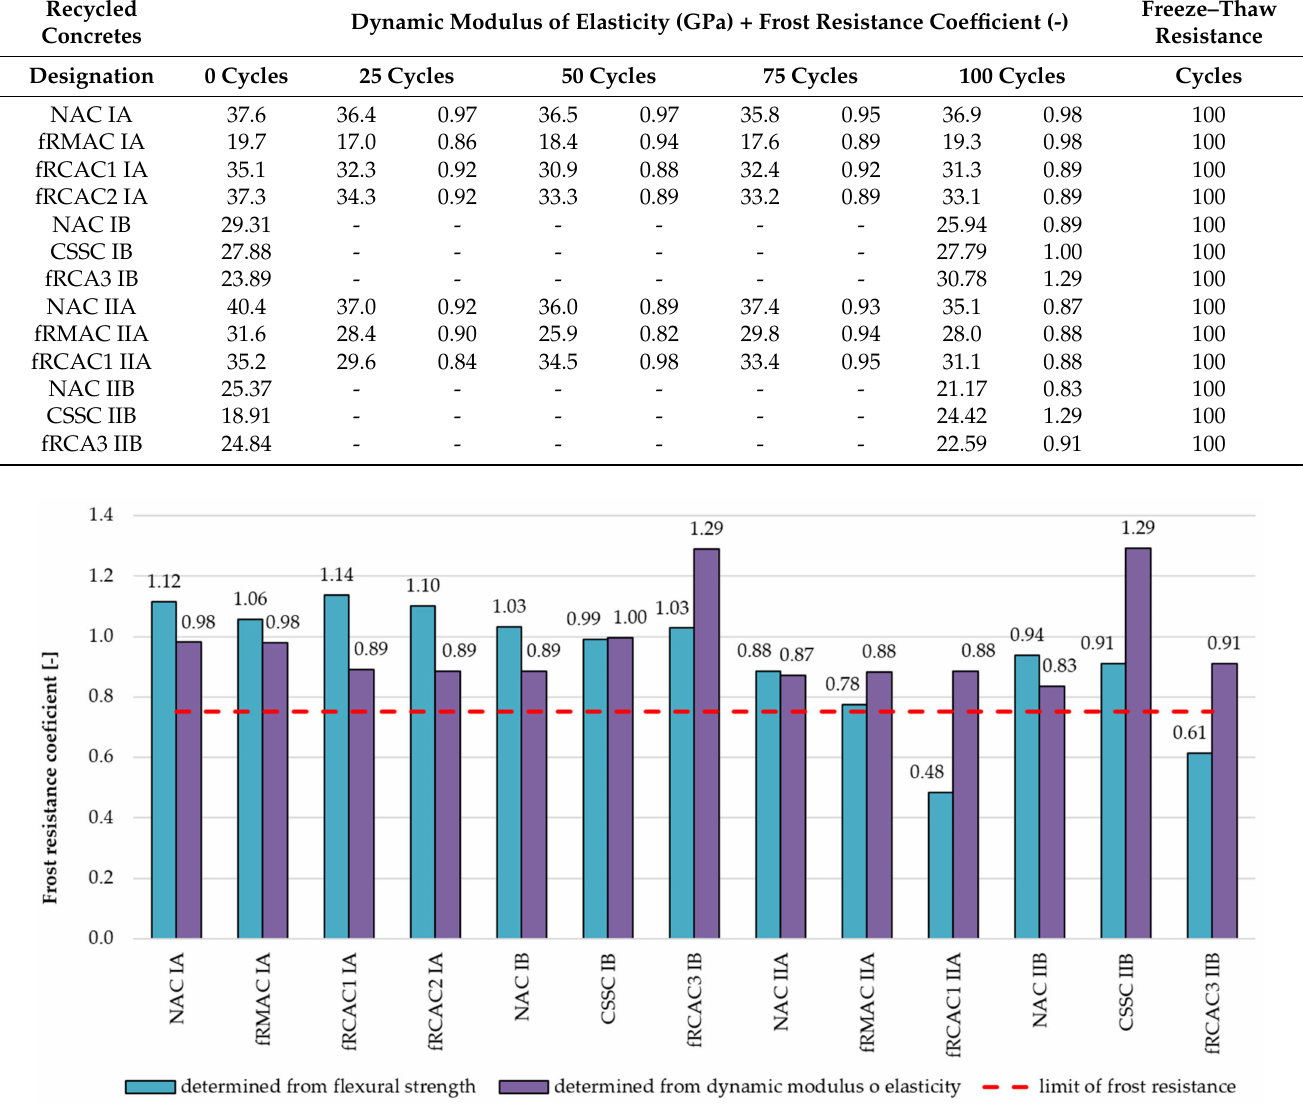
Figure 11. Comparison of frost resistant coefficient calculated from flexural strength and dynamic modulus of elasticity of concrete containing fNA, fRCA, and fRMA measured before and after 100 freeze–thaw